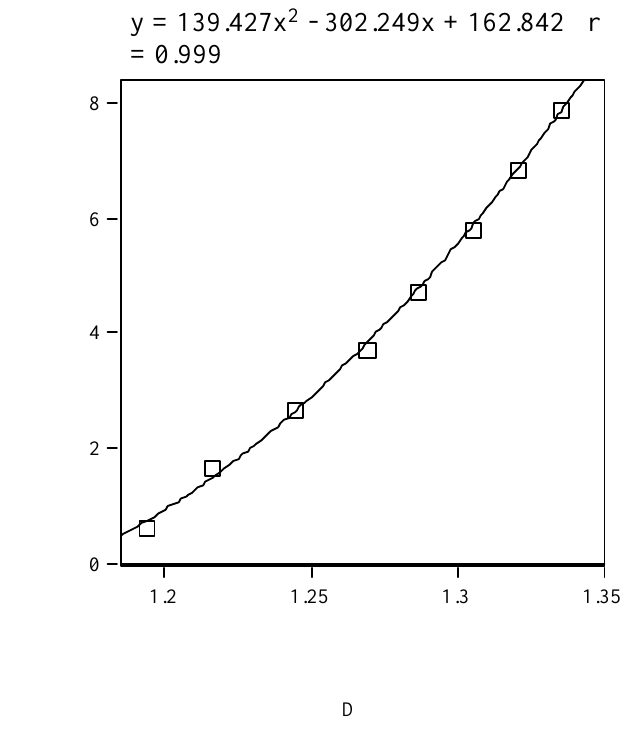
Figure 3. 1-Octanol–water partition coefficient of homologous phenyl alcohols vs . the fractal